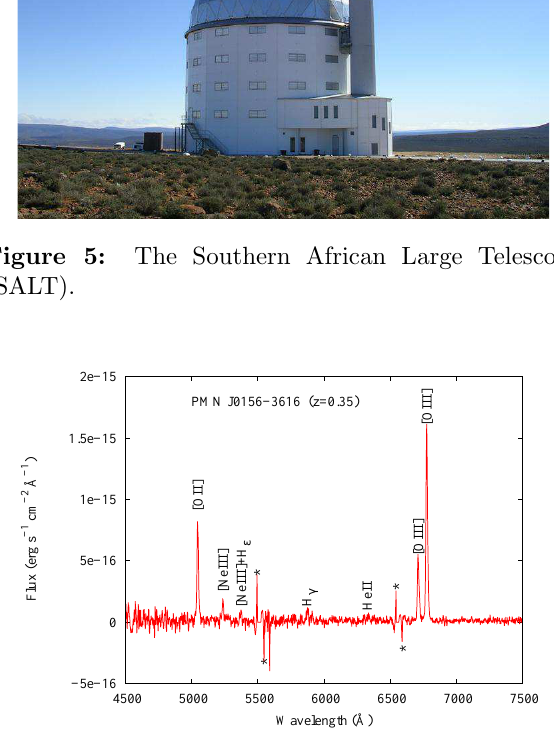
Figure 6: SALT spectrum of the optical counterpart of the unidentified EGRET source 3EG J0159-3603, show- ing emission lines redshifted by